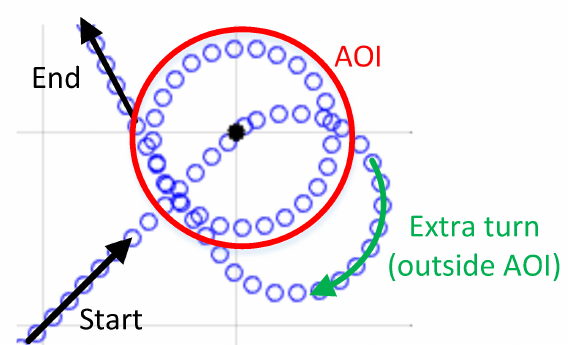
Figure 1. Fly through loiter path